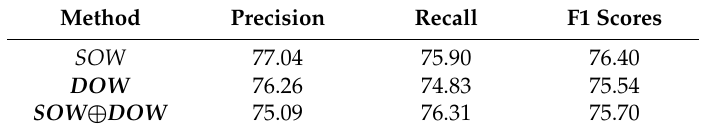
Table 7. Results of un-normalized representation of sentence vectors on SemEval-2016 dataset.